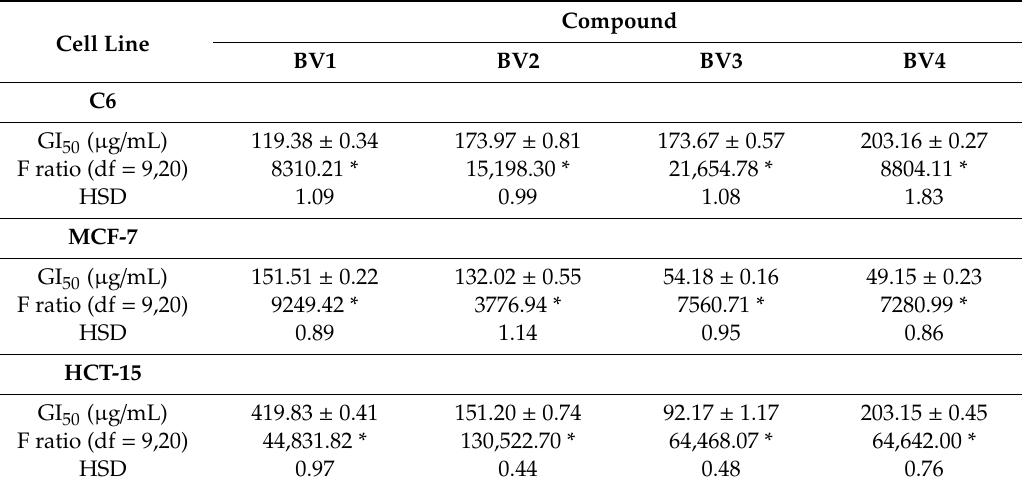
Figure 6. The percentage cytotoxic activity of compounds isolated from Bauhinia variegata L. bark against C6 cell line. BV1 = kaempferol; BV2 = stigmasterol; BV3 = protocatechuic acid methyl ester; BV4 = protocatechuic acid. Table 7. GI 50 , one-way ANOVA F-ratio and HSD values of cytotoxic activity of compounds isolated from Bauhinia variegata L. bark against C6, MCF-7 and HCT-15 cell